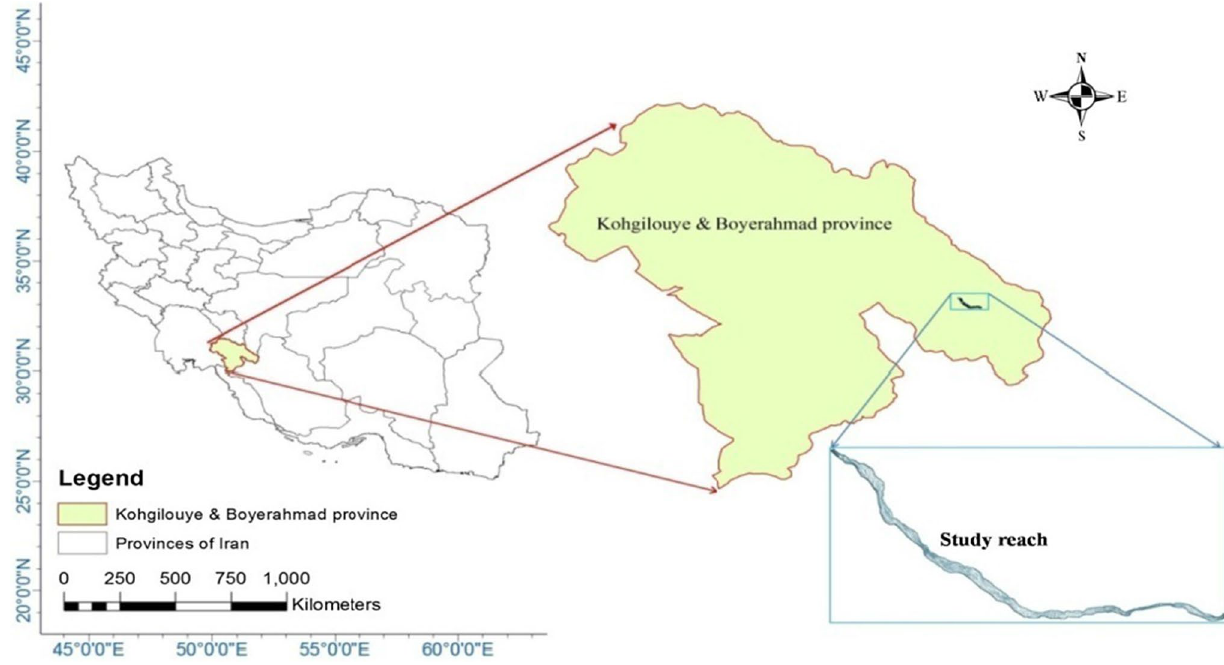
Fig. 1 Position of the study